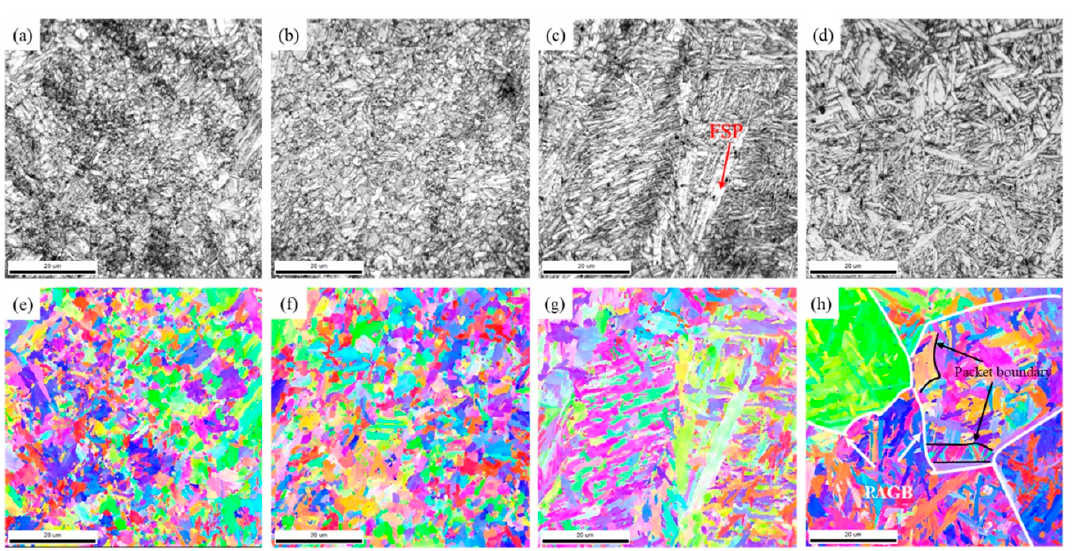
Figure 6. EBSD image quality (IQ) and inverse pole figure (IPF): ( a ) and ( e ) columnar grain zone of TIG; ( b ) and ( f ) reheated zone of TIG; ( c ) and ( g ) columnar grain zone of SAW; ( d ) and ( h ) reheated zone of SAW.